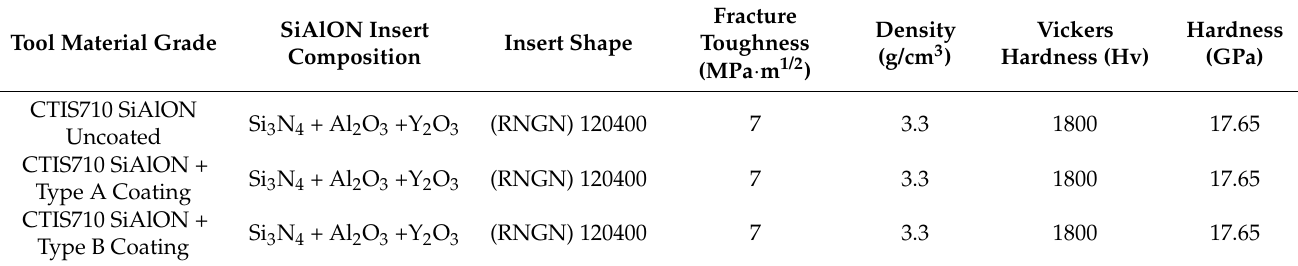
Table 1. Physical properties of uncoated and CVD-coated SiAlON ceramic milling inserts as provided by the